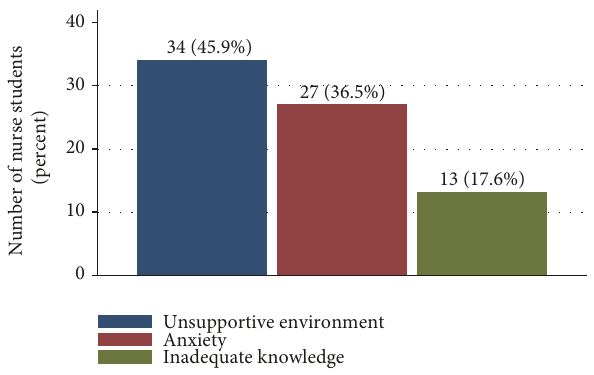
Figure 2: Barriers preventing effective performance in clinical